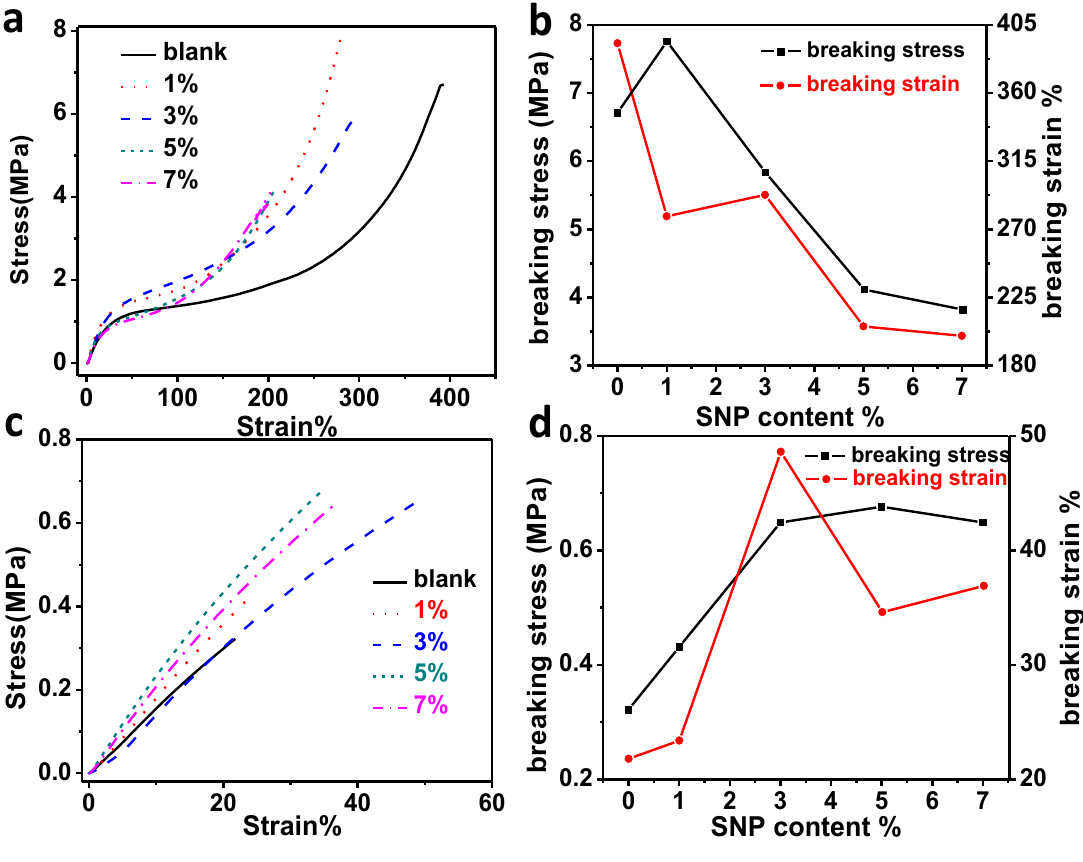
Figure 4. Stress-Strain curves and breaking stress/strain plot of xLCNs/SiO (xLCN/SNP) and blank xLCN sample at ( a , b ) 90 °C and ( c , d ) 160